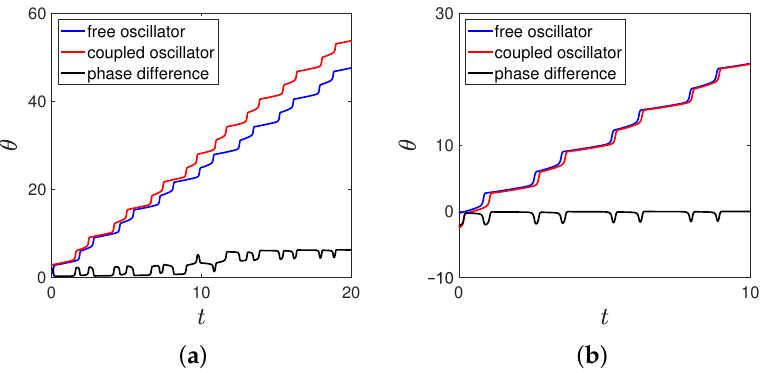
Figure 6. The effect of unidirectional coupling between two FHN oscillators. ( a ) The coupled oscillator leads the free oscillator, ( b ) the coupled oscillator falls behind the free oscillator. In the ring-shaped neural network, the initial phases of all the neurons are